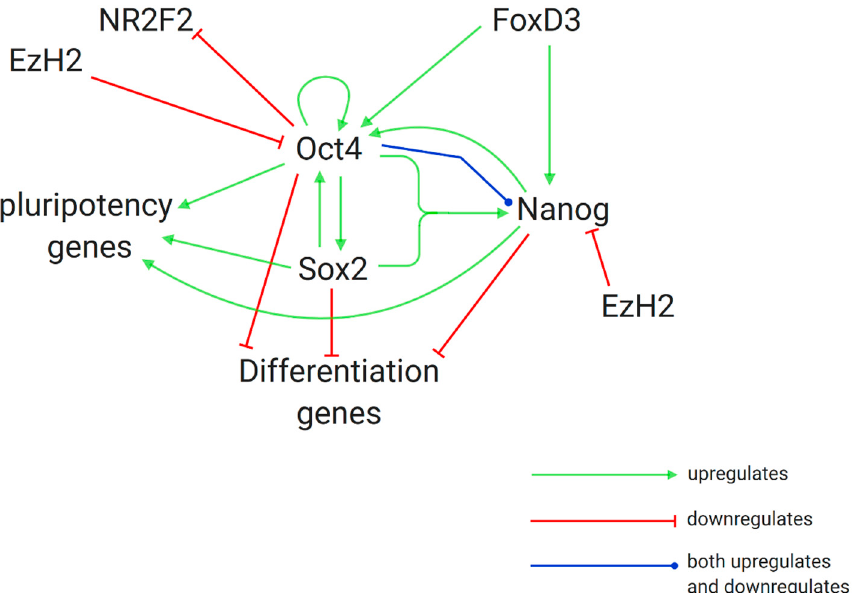
Figure 3. Maintenance of pluripotency vs. di ff erentiation in hESCs and the role of the histone modifier EZH2. OCT4 , SOX2 and NAOG , key genes in maintenance of pluripotency in hESCs, form a complex interdependent regulatory network. The histone modifier EZH2 disturbs the balance of this regulatory circuit and thereby triggers di ff erentiation by silencing transcription of the genes which translate the OCT4 and NANOG products [72,73].